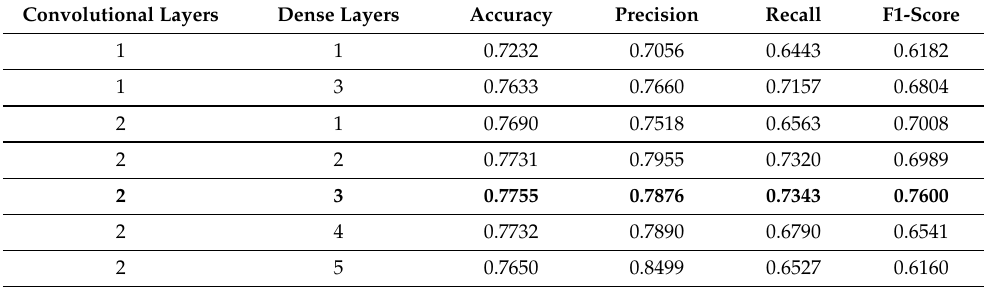
Table 5. A comparison of CNN layers for multi-class sub-category classification.